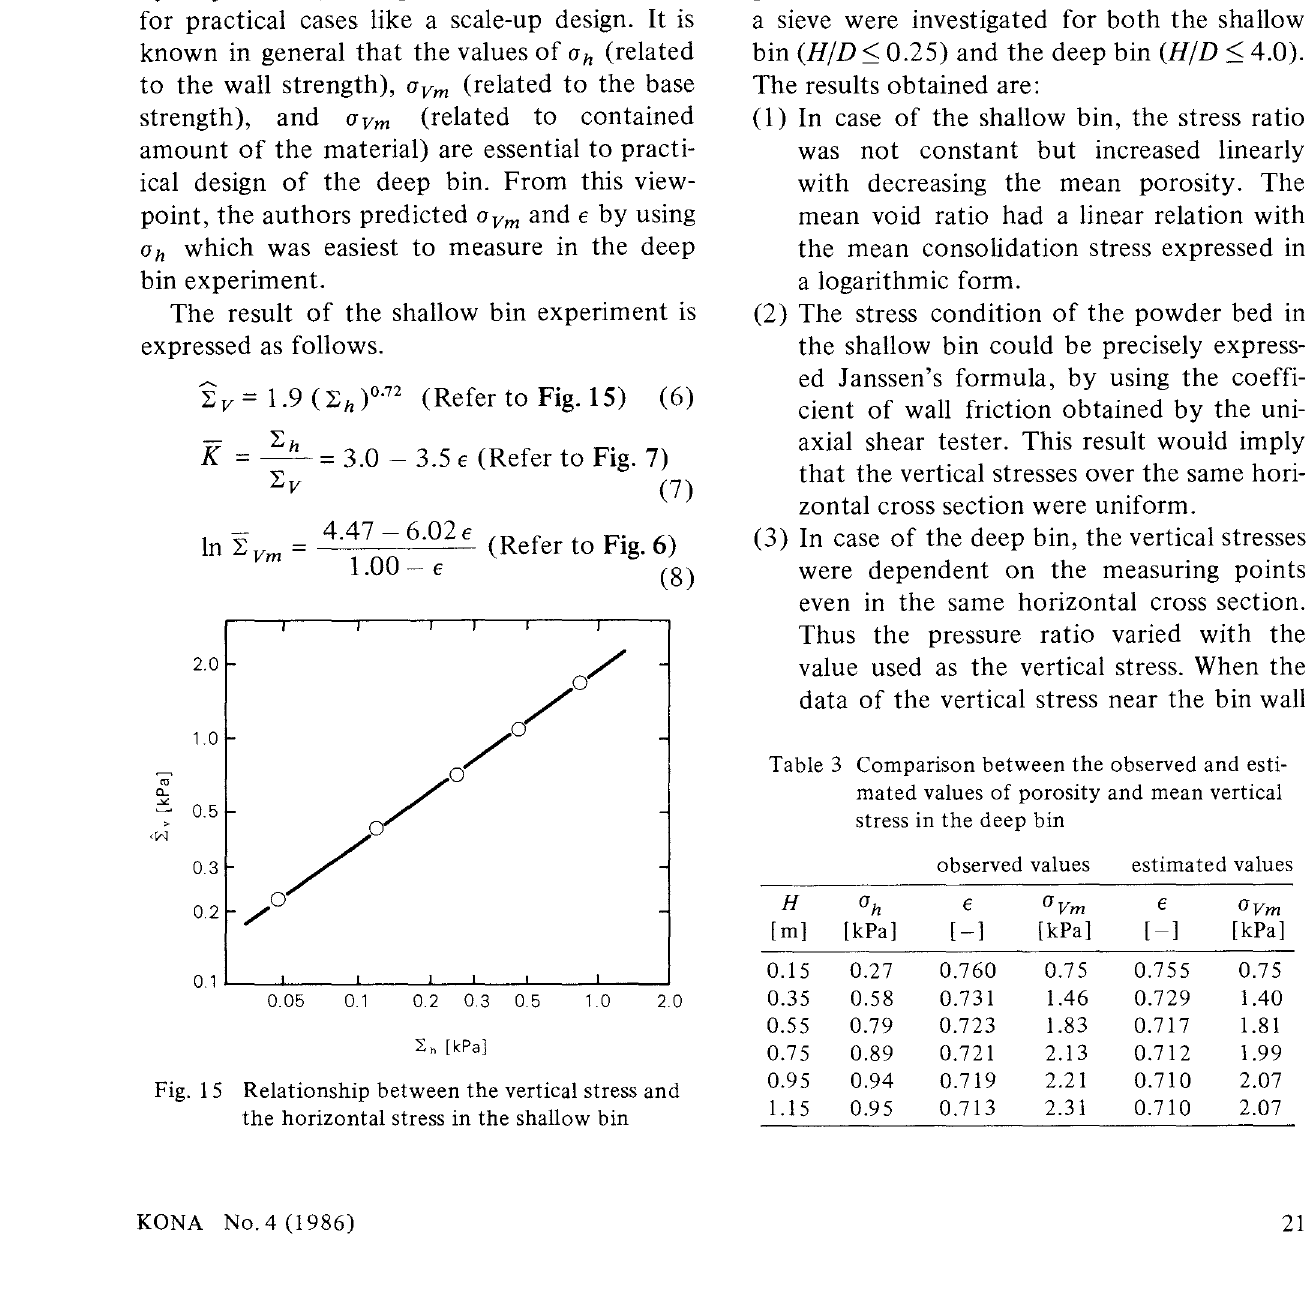
Table 3 Comparison between the observed and esti- mated values of porosity and mean vertical stress in the deep bin observed values estimated